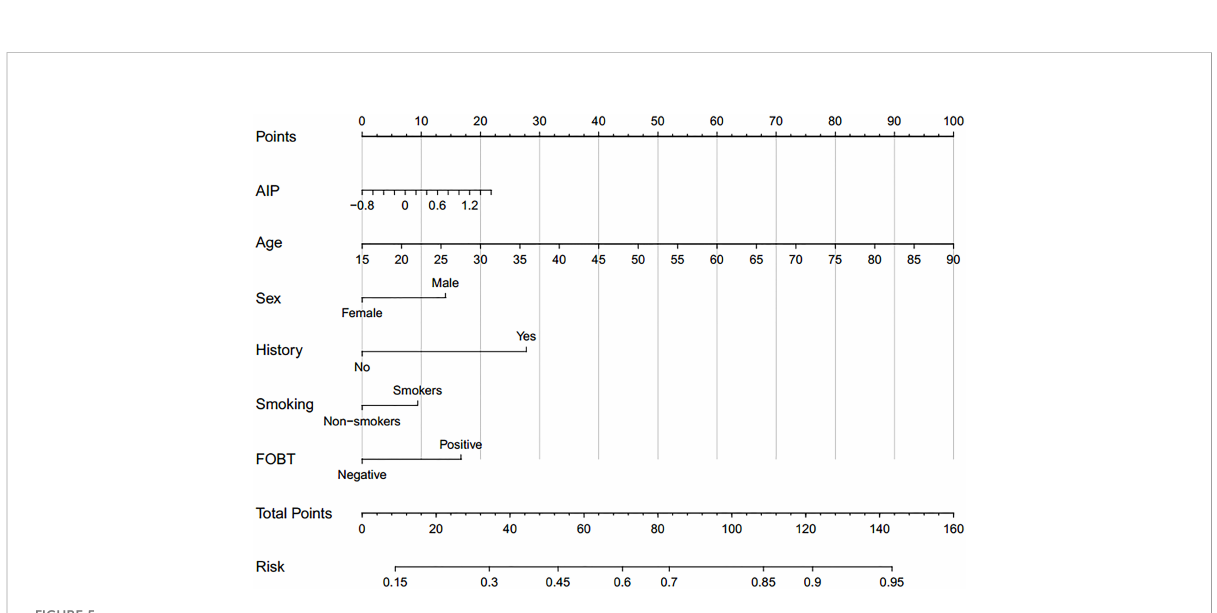
FIGURE 5 Nomogram for model 2 calculate individual neoplasm